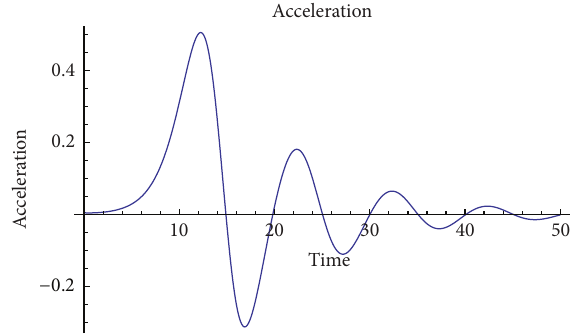
Figure 10: The fast stabilization of acceleration for ] = 2, 𝜀 = 5, 𝐵 = 1000, ] ̸= 0 .